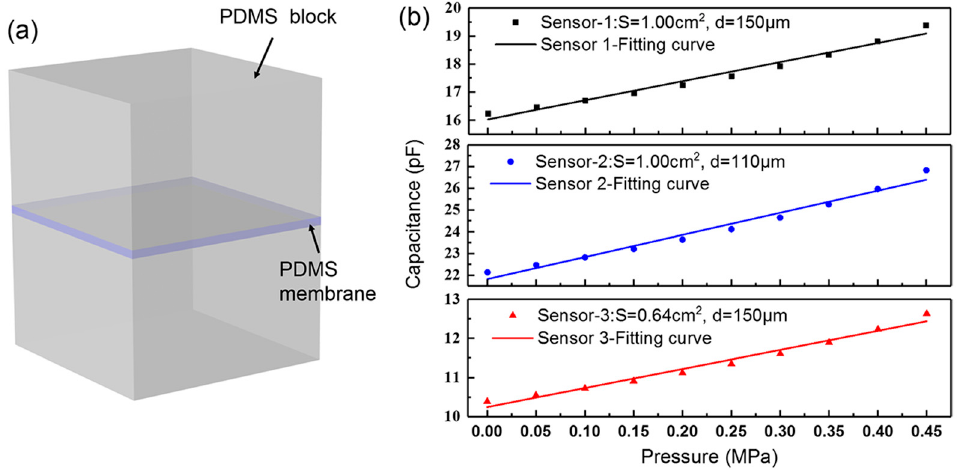
Figure 2. Simulation of the PDMS (polydimethylsiloxane)-based sensors under pressure. ( a ) Simplified geometric model of the capacitive sensor; ( b ) capacitance change of the sensors with different dimensions under pressure.